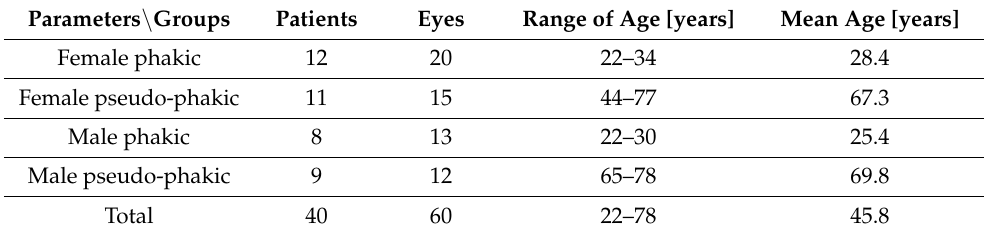
Table 1. A demographic table of the